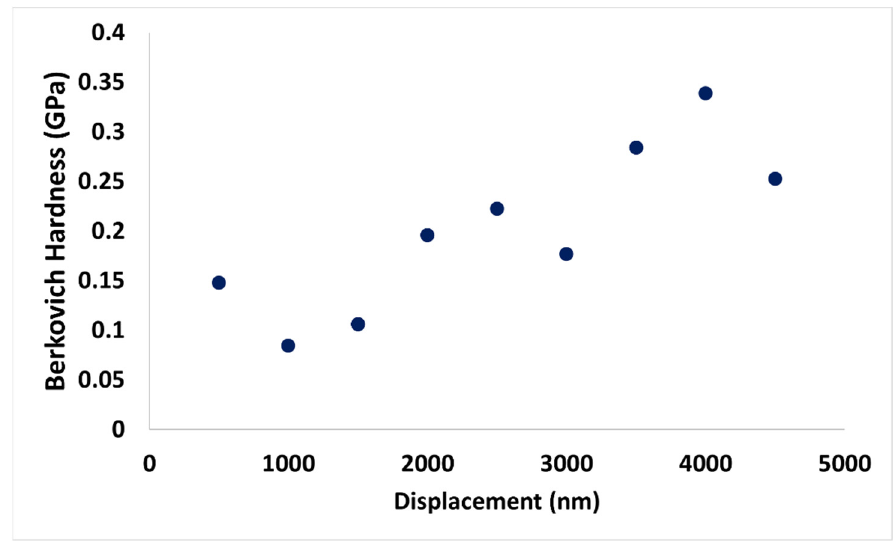
Figure 6. Berkovich hardness value measured on nanocomposite coating using nanoindentation.